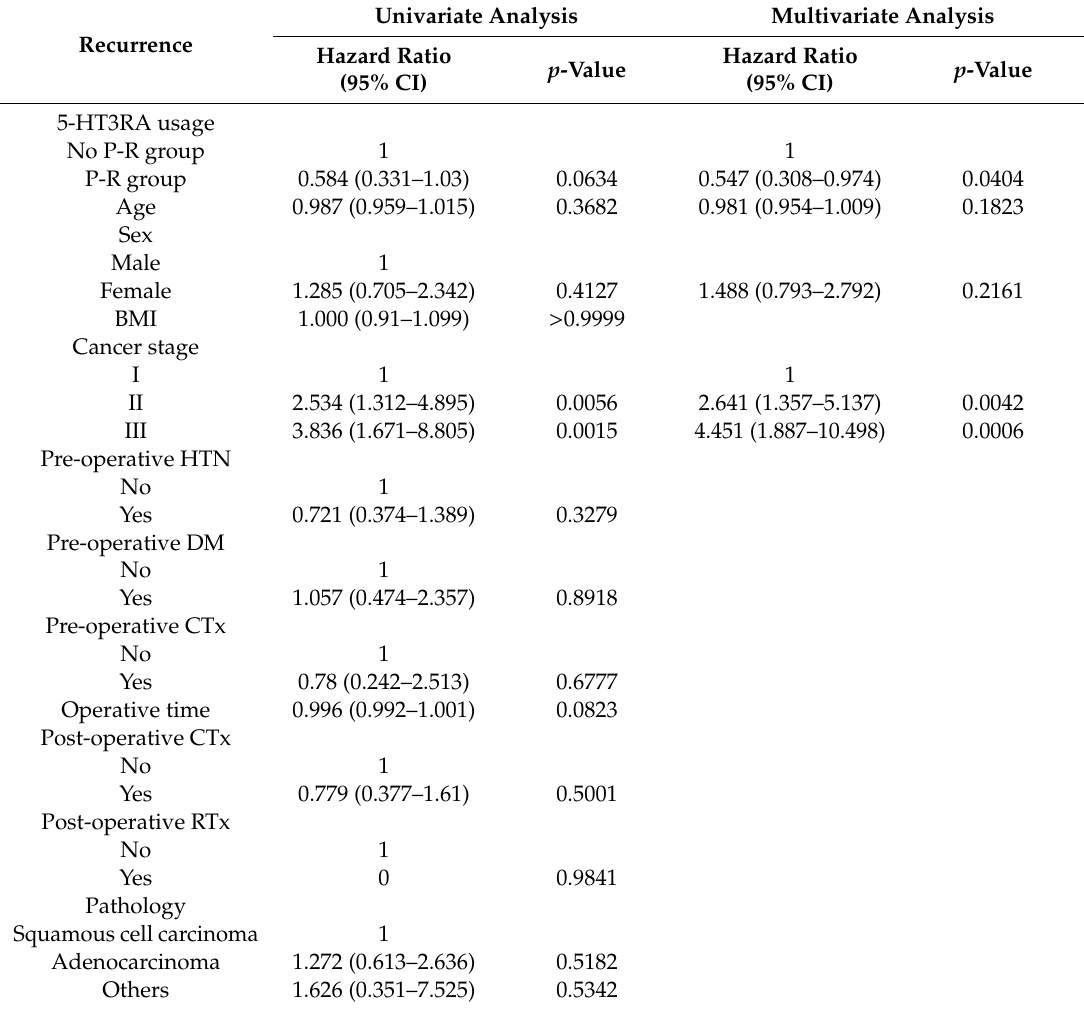
Table 2. Univariate and multivariate regression analysis of variables after propensity score matching with recurrence after open lung surgery for lung